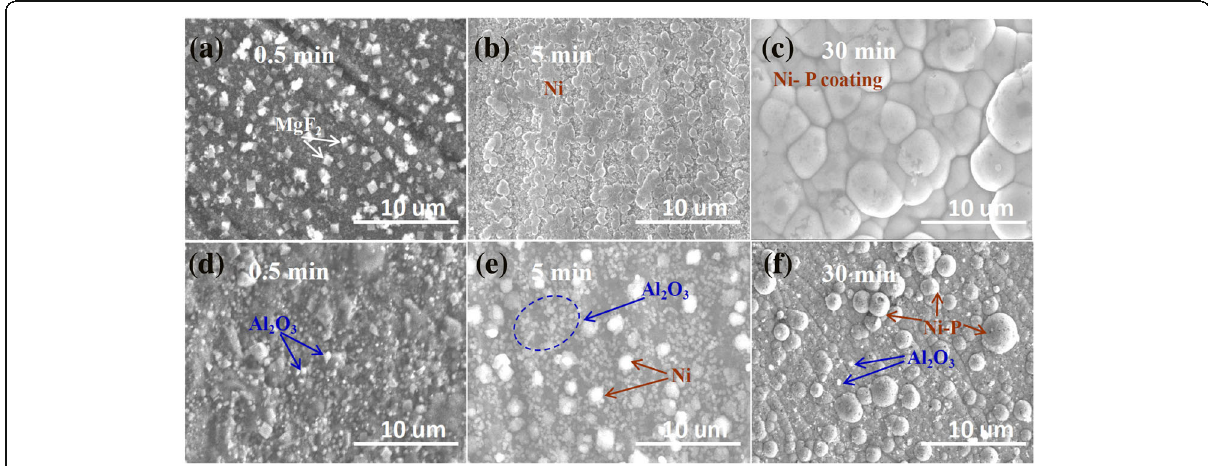
Fig. 2 Surface morphology of Ni-P coating (top, a - c ) and Ni-P-Al 2 O 3 composite coatings (bottom, d - f ) at different deposition